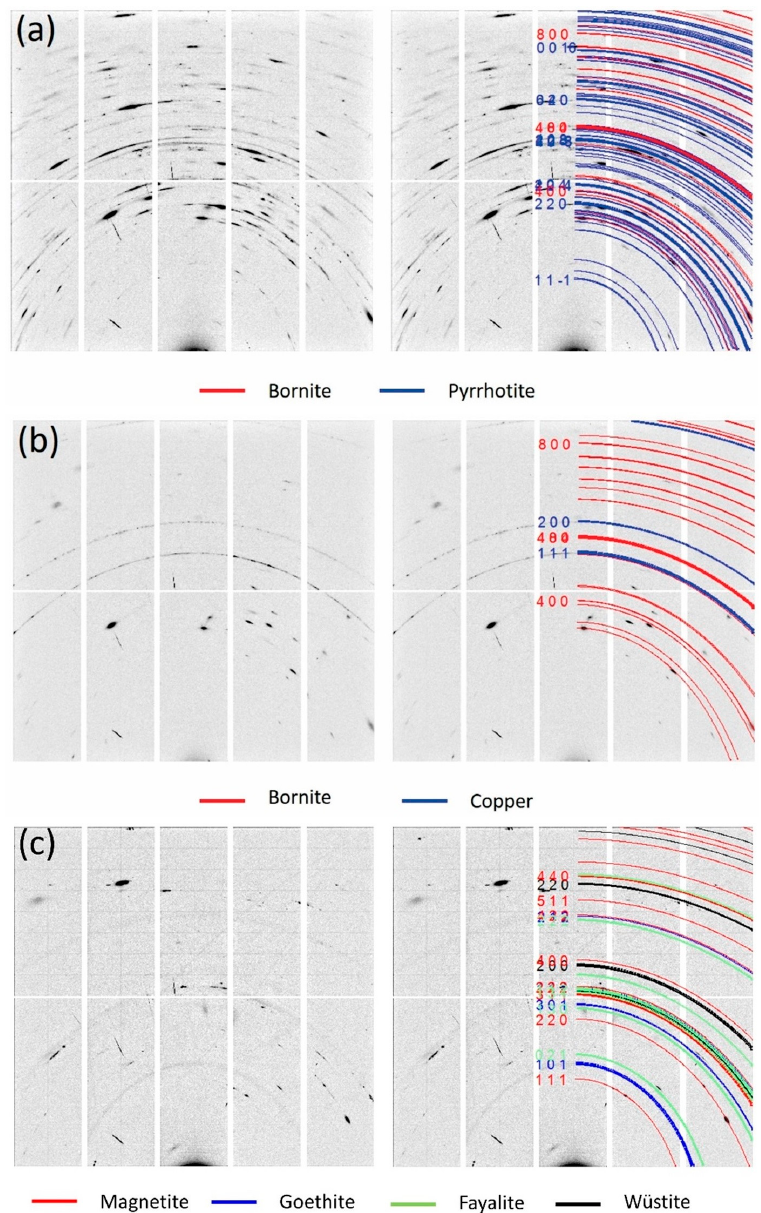
Figure 14. Microfocus synchrotron X-ray diffraction images of ( a,b ) non-magnetic and ( c ) magnetic slag. On the left side is the diffraction image, on the right side mineral phases are superposed and identified with colors; ( a ) corresponds to the circular region in Figure 8b, ( b ) to left side of Figure 8d and ( c ) to Figure 12d.